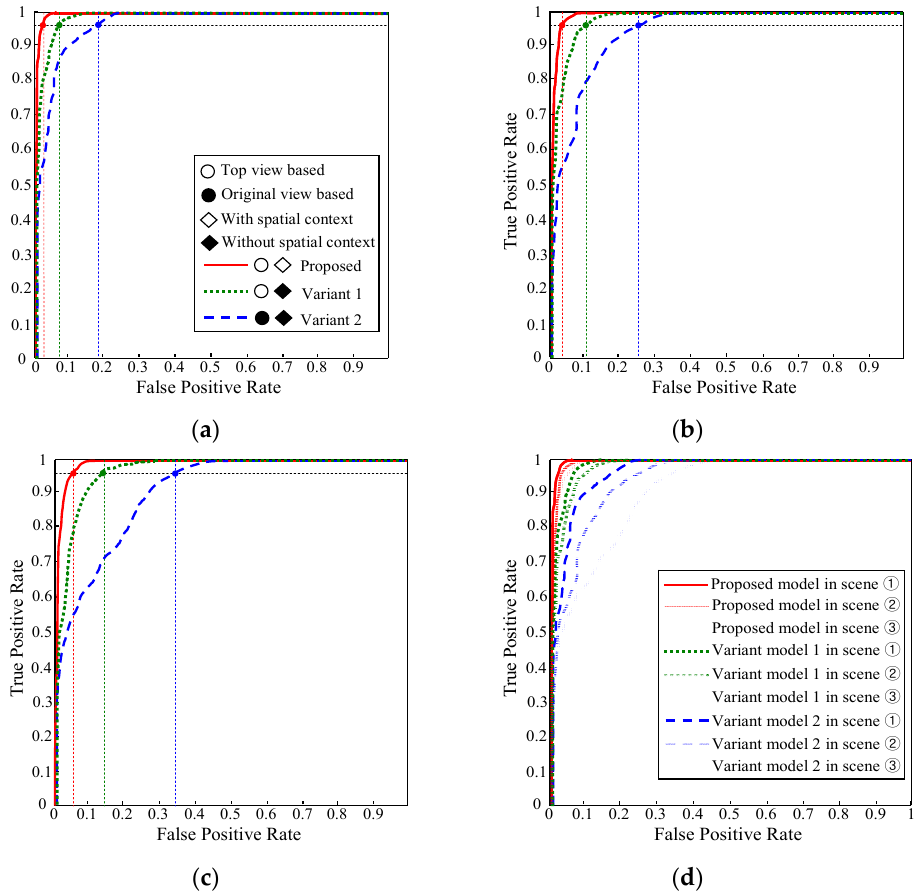
Figure 20. ( a ) Far-field model performances in test scene ① ; ( b ) Far-field model performances in test scene ② ; ( c ) Far-field model performances in test scene ③ ; ( d ) Far-field model performances in all three test scenes.